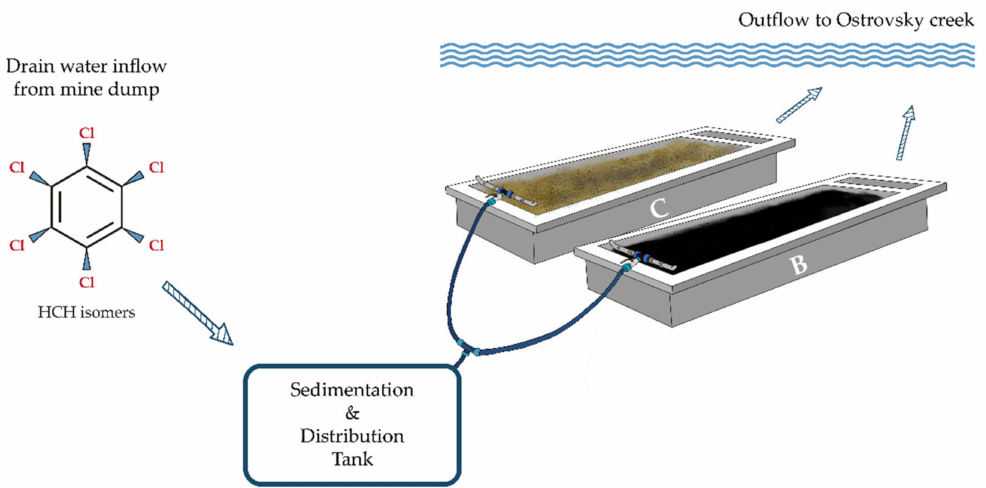
Figure 1. Schematic illustration of the constructed two-part biofilter used in this study, B—biochar biofilter, C—control biofilter filled with a soil/clay substrate and natural